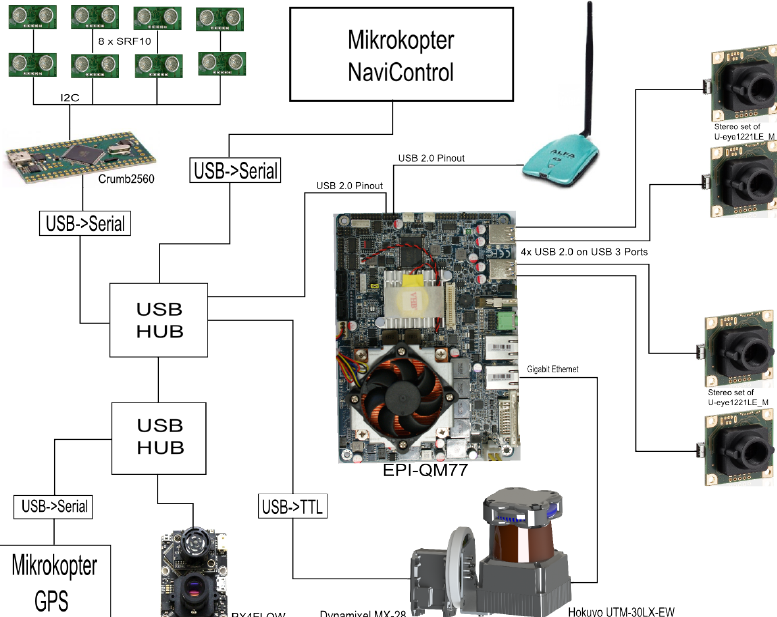
Figure 2: Schematic overview of the onboard communication on our UAV. The main compute unit is connected to a plurality of sensors, i.e., two stereo-camera pairs, the 3D laser scanner, eight ultrasonic sensors (via microcontroller board), an optical flow camera, and a GPS sensor. Our UAV is controlled using an extended version of the MikroKopter debug and control protocol. The downlink to a base station computer is provided by a high-power wireless